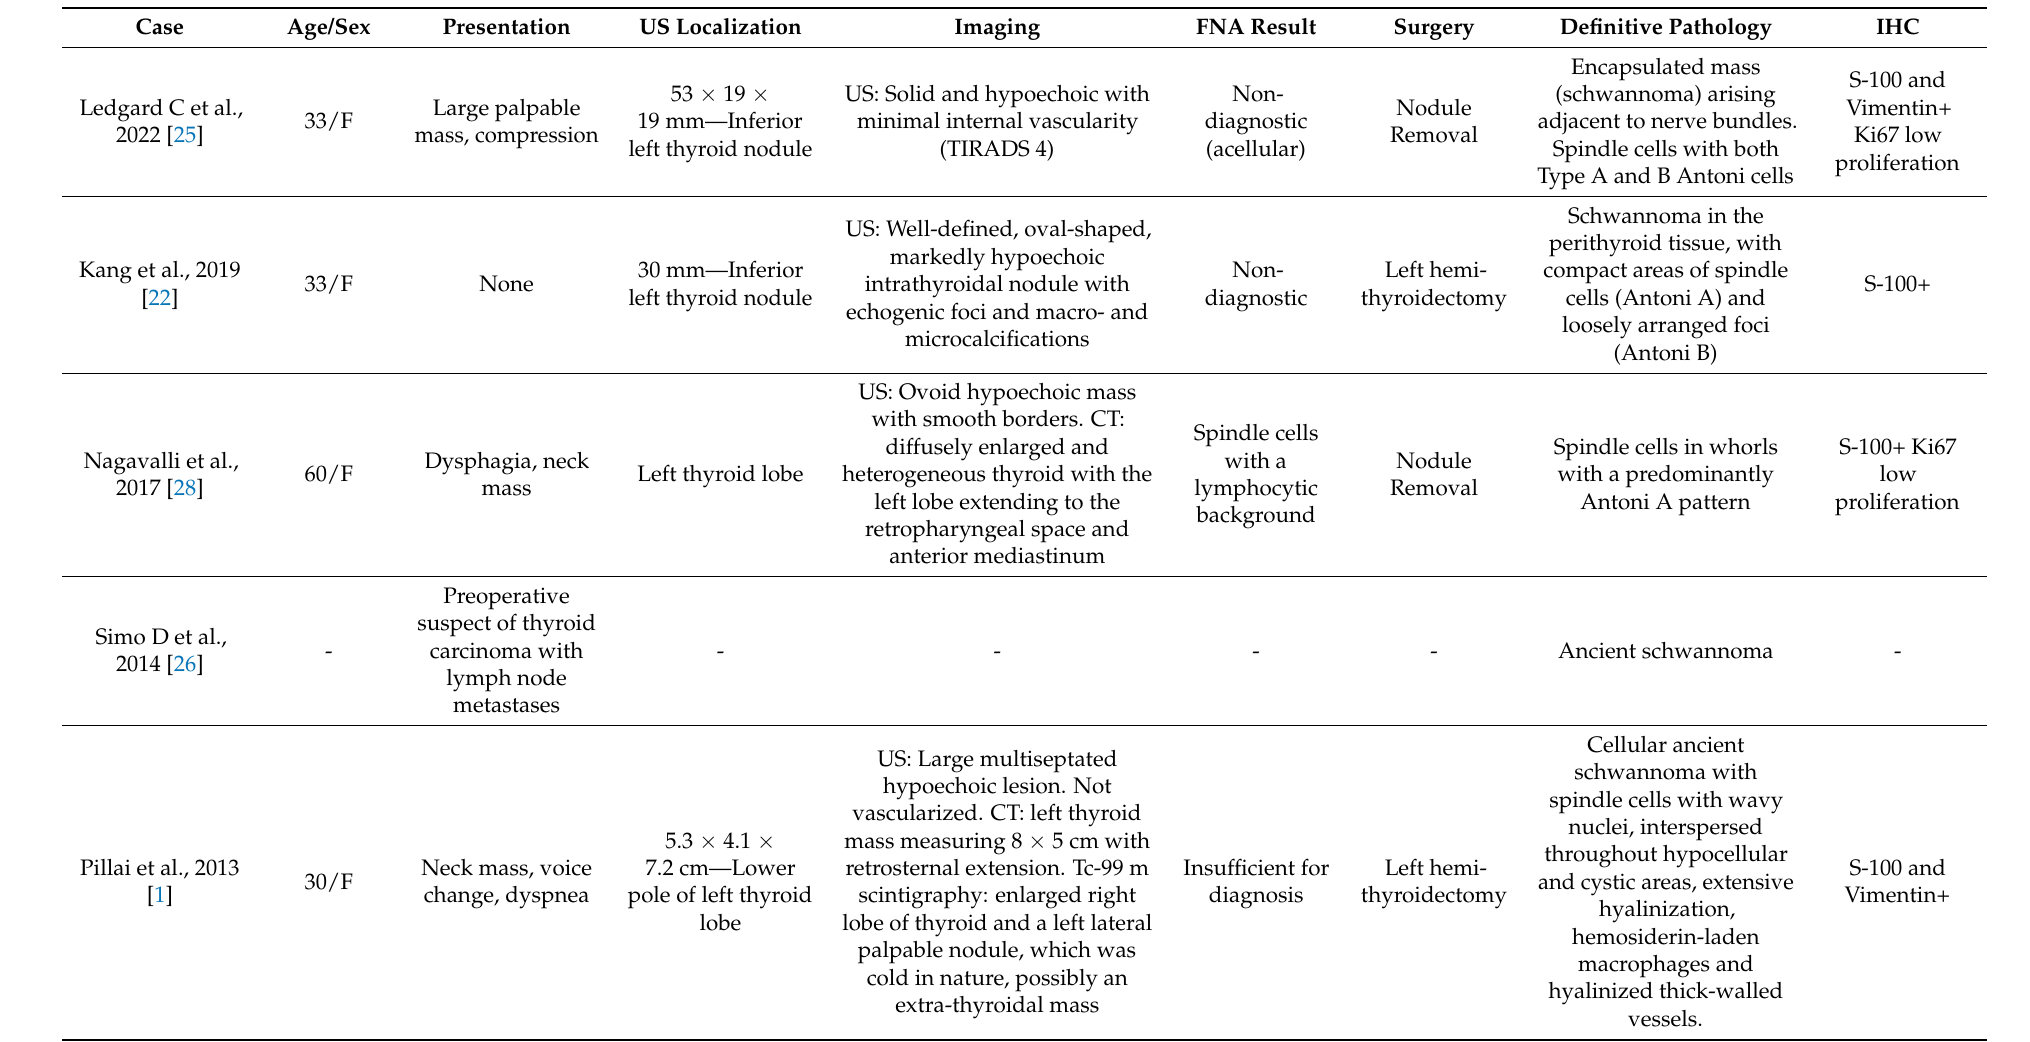
Table 1. Demographic, clinical, and histological features of patients affected by thyroid-bed schwannoma misinterpreted as thyroid